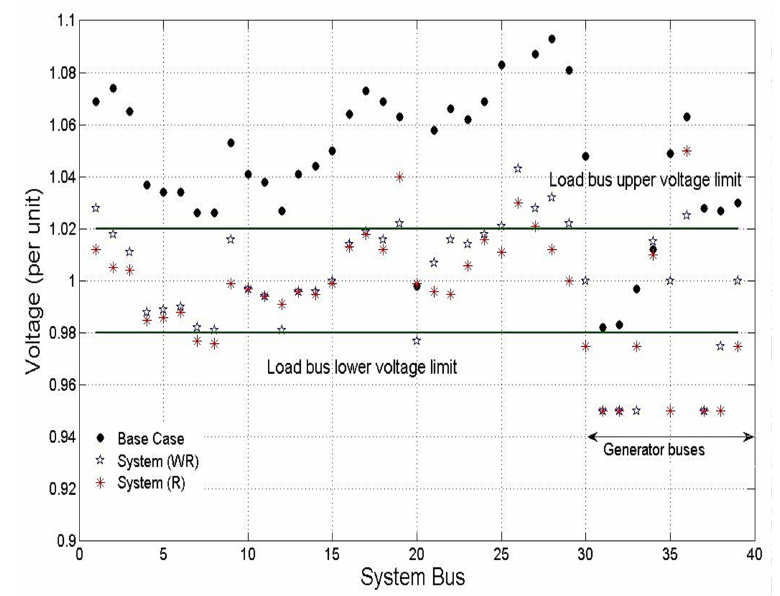
Figure 12. System voltage profiles for the base case, post-game without renewable (WR) and with renewable (R) sources. Table 7. Comparison of automatic voltage regulator (AVR) settings for all three cases. Bus Base Post-Game